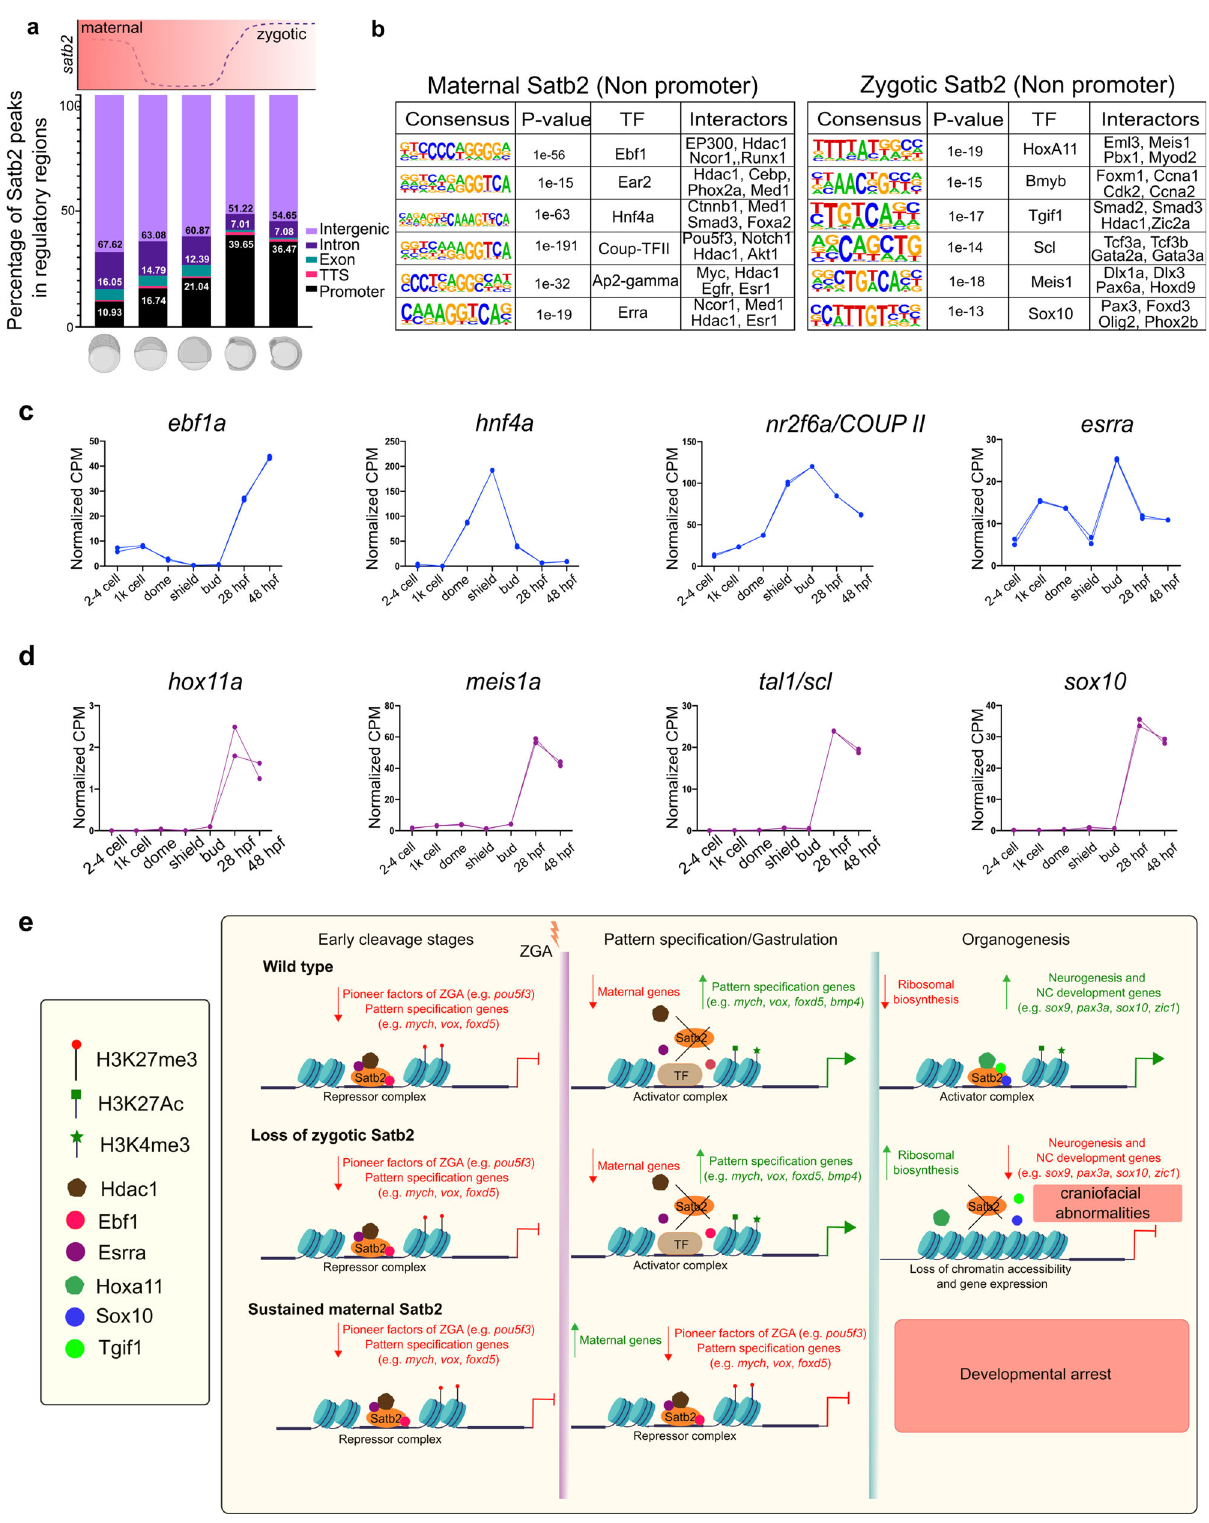
Fig. 7 Differential mechanisms employed by maternal and zygotic Satb2 to perform contrasting functions during embryogenesis. a Genomic distribution of Satb2 bound regions across developmental stages highlighting a shift in the ratio of non-promoter to promoter bound peaks. Schematic above the bar plot represents the expression pattern of satb2 throughout early embryogenesis. b TFBS for transcription factors at maternal (512 cells stage) and zygotic (14 ss) Satb2. Known interactors for each transcription factor are enlisted. c Line graph depicting mRNA expression dynamics for putative interactors of maternal Satb2; ebf1a , hnf4a , nr2f6a, and esrra across developmental stages as indicated on the x -axis. d Line graph depicting mRNA expression dynamics for putative interactors of zygotic Satb2 namely, hox11a , meis1a , tal1 , and sox10 , across developmental stages as indicated on the x -axis. e Schematic summary highlighting differential functions of Satb2 during various stages of zebra fi sh